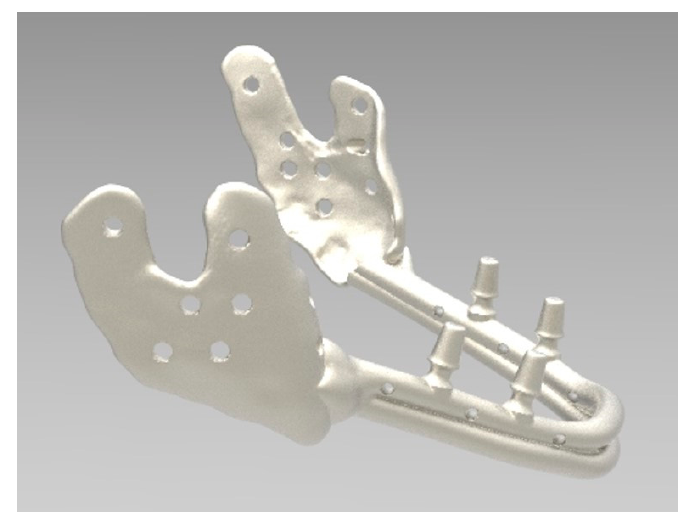
Int. J. Environ. Res. Public Health 2020 , 17 , x 14 of 14 Figure 8. Lateral view of the same computer-aided-design (CAD) design. Figure 8. Lateral view of the same computer-aided-design (CAD) design.